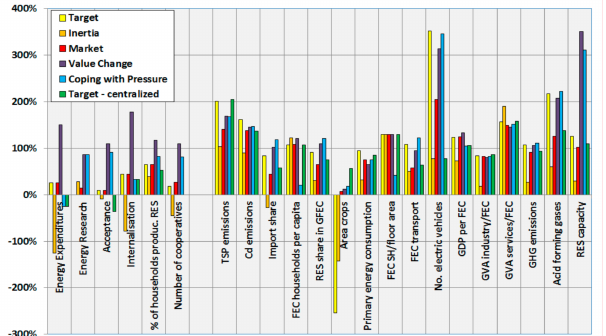
Figure 5. Compilation of performance results for all 22 indicators and all 6 selected scenarios analyzed in this